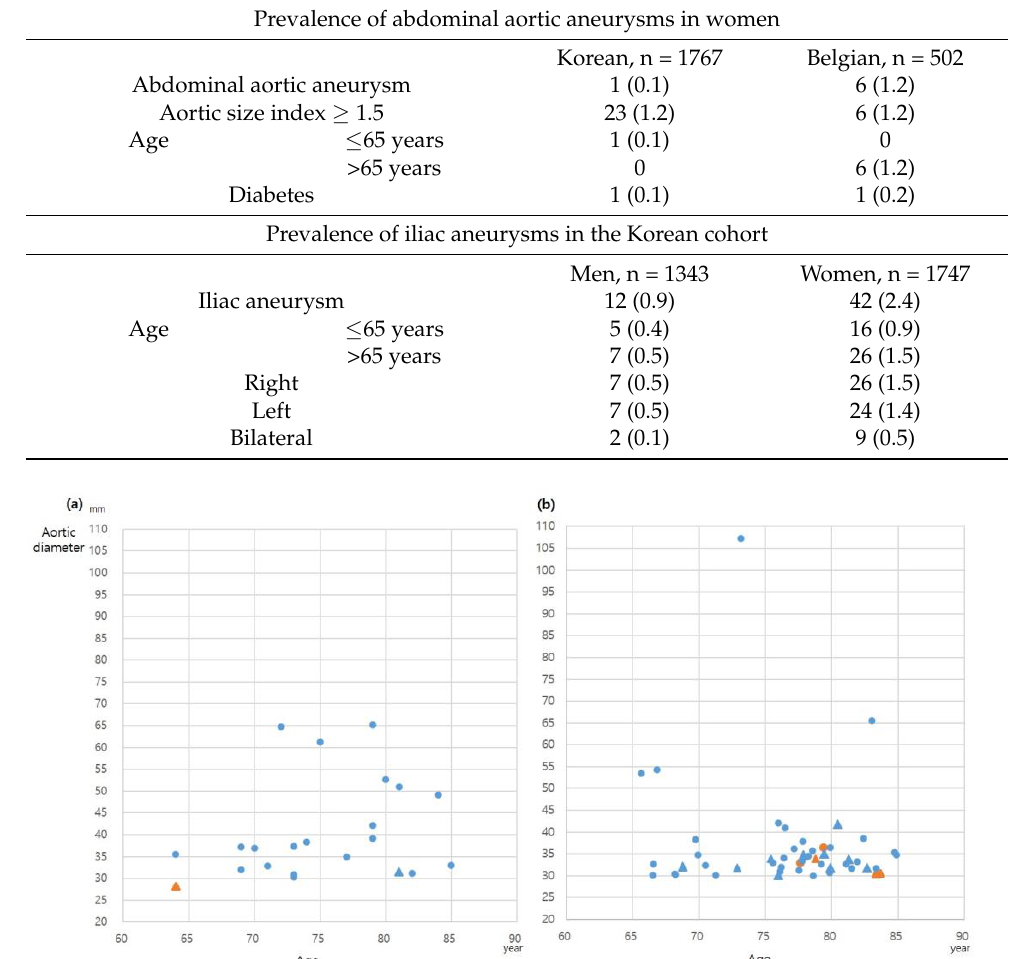
Figure 3. Distribution of participant age and diameter of abdominal aortic aneurysms: ( a ), Korean (n = 22); ( b ), Belgian (n = 51). blue, men; orange, women; circle, smoker; triangle, nonsmoker.